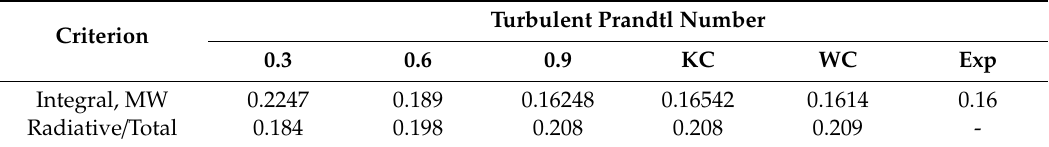
Table 3. Influence of the turbulent Prandtl number approach.